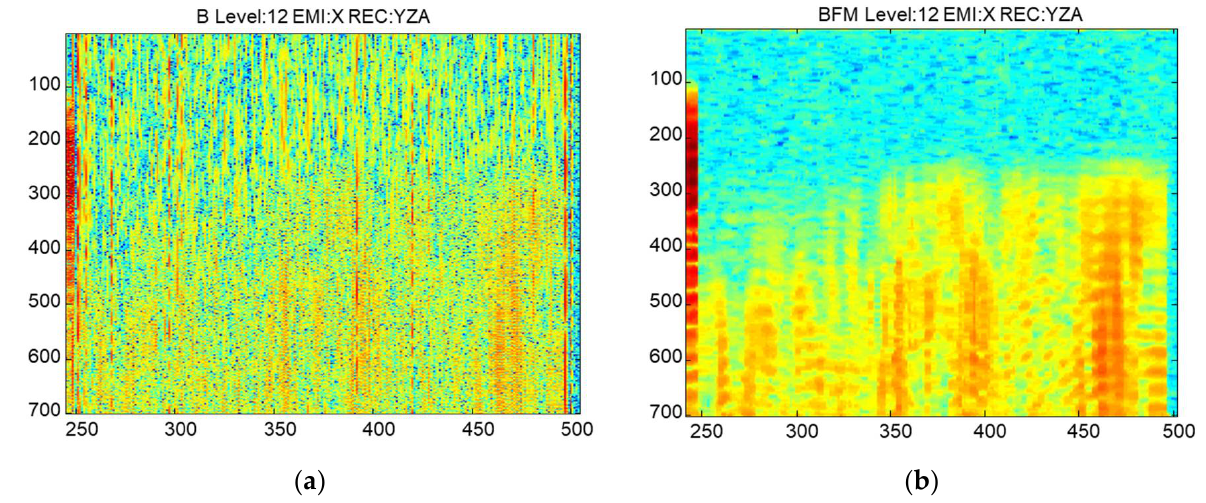
Figure 14. Signal processing. ( a ) Received signal without processing and ( b ) processed. The x and the y-axes represent the emitter and receiver positions, respectively.